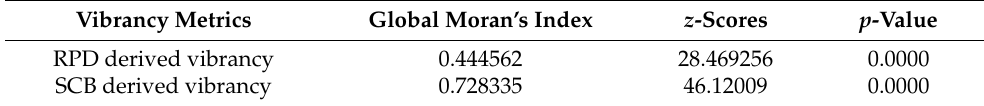
Table 3. Global spatial autocorrelation analysis of urban